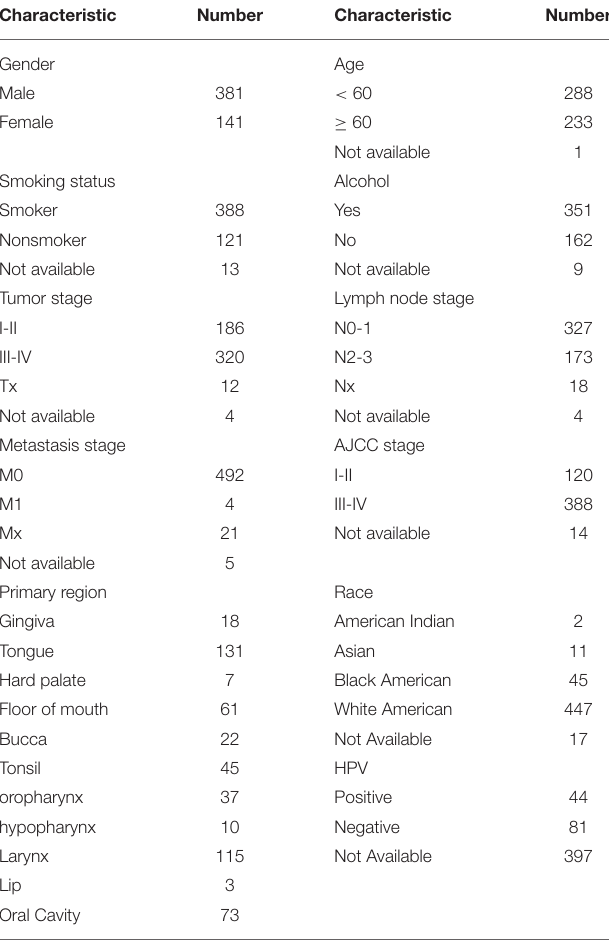
TGFB1, and STAT3 were significant ( P < 0.05) between tumors and normal tissues ( Figure 1